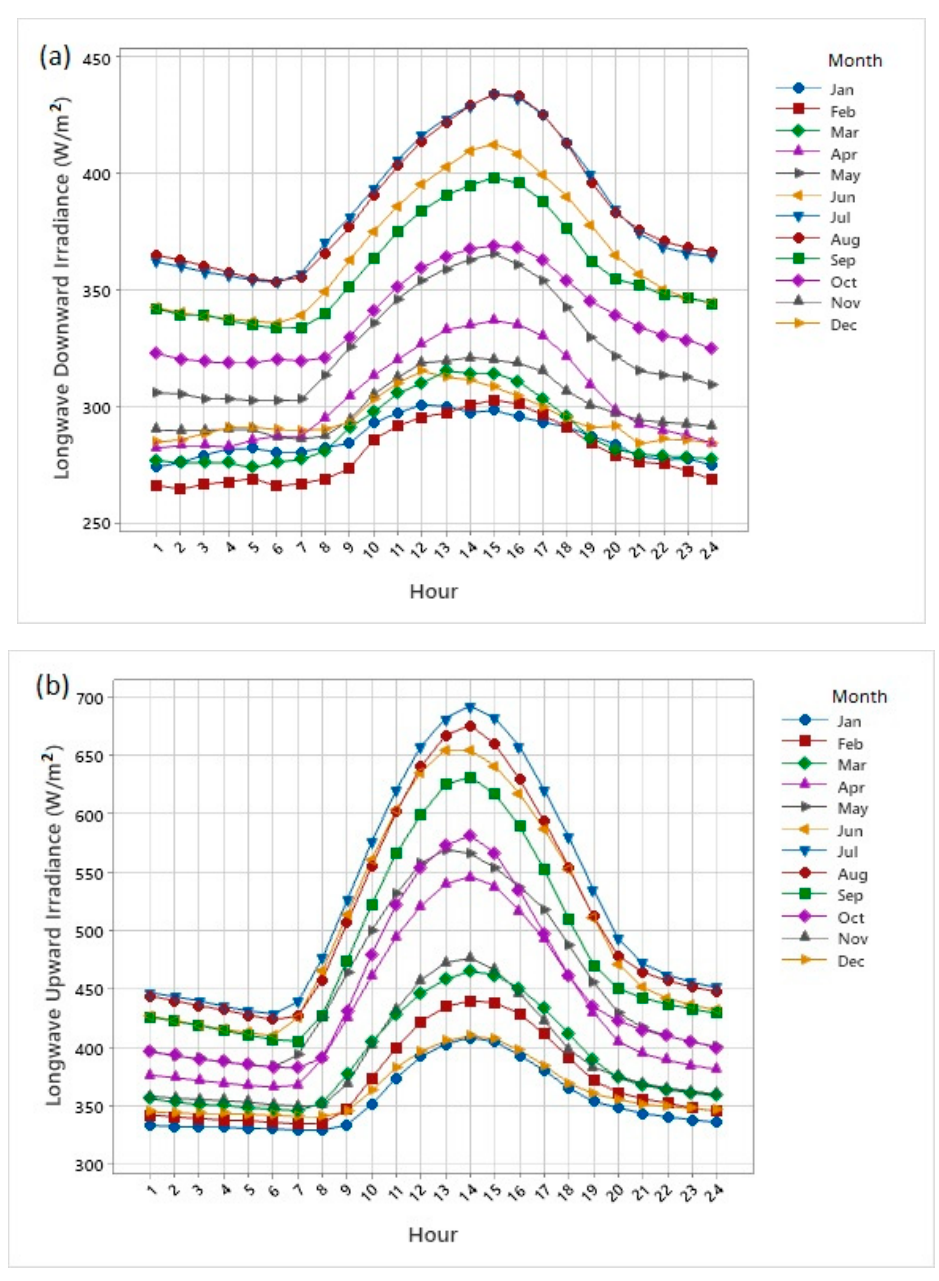
Figure 6. Diurnal variation of the ( a ) downward ( L dn ), ( b ) upward ( L up ), ( c ) net longwave irradiances ( R nl ) ( d ) ground surface temperatures ( T g ) and ( e ) Annual variability of the hourly estimated effective air emissivity ( ε a